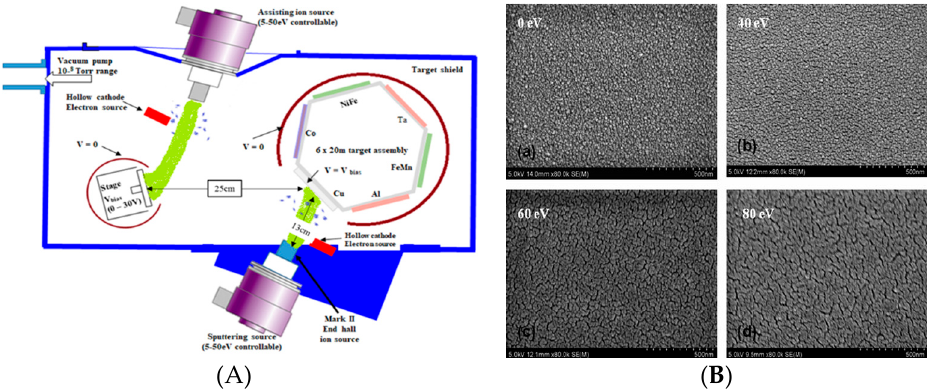
Figure 11. ( A ) Diagram of the biased target ion beam deposition, ( B ) SEM images of thin film surfaces deposited via ion beam deposition process. Reprinted with permission from [116]. Copyright 2014 Taylor & Francis.